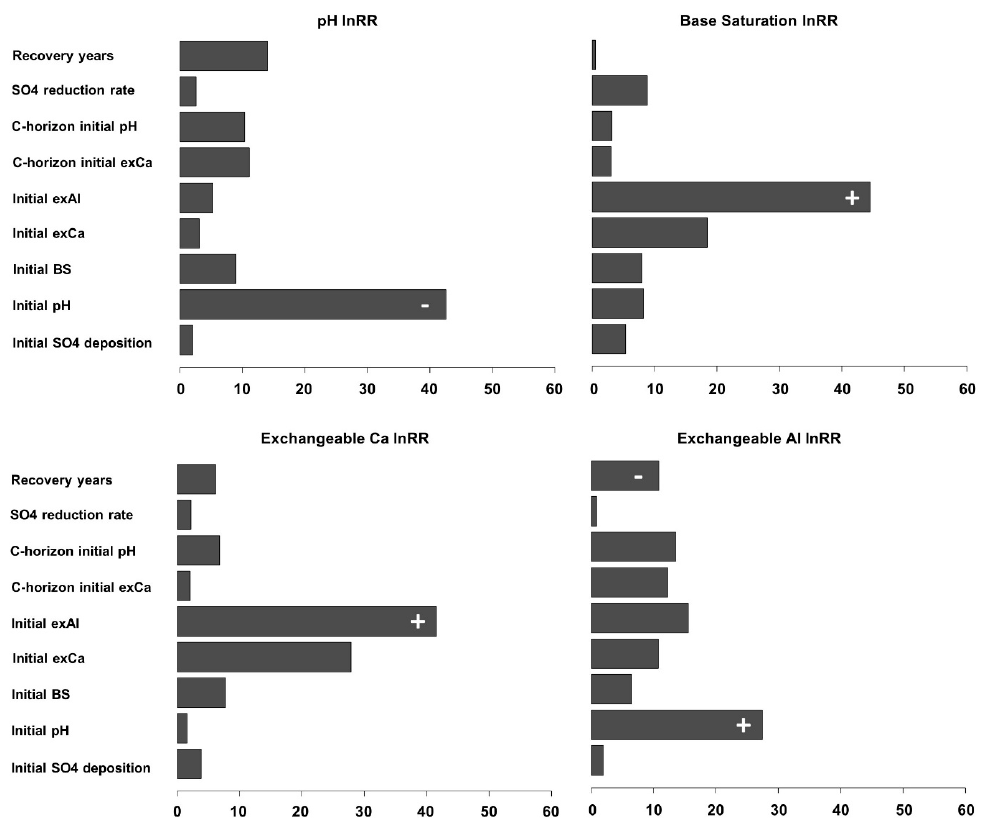
Figure 7. Independent contribution (%) of each explanatory variable for O horizon soil recovery indices based on hierarchical partitioning. +/ − signs denote direction of significant contribution ( p < 0.05) based on a negative log-likelihood randomization test ( n = 1000).